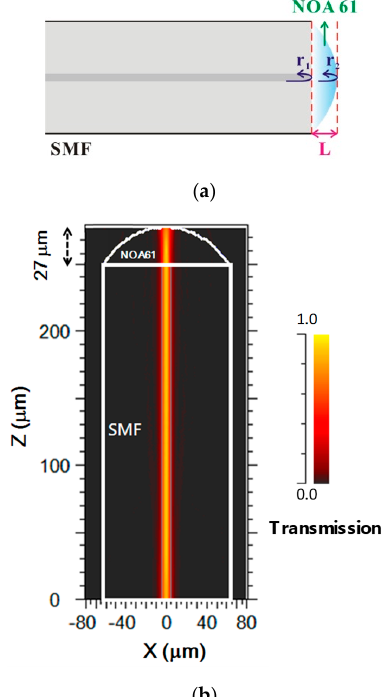
Figure 2. ( a ) Schematic diagram of light propagation characteristics in the resonant cavity of a PMCFFI; ( b ) The transmission of the designed sensing device with the PMCFFI (27 µ